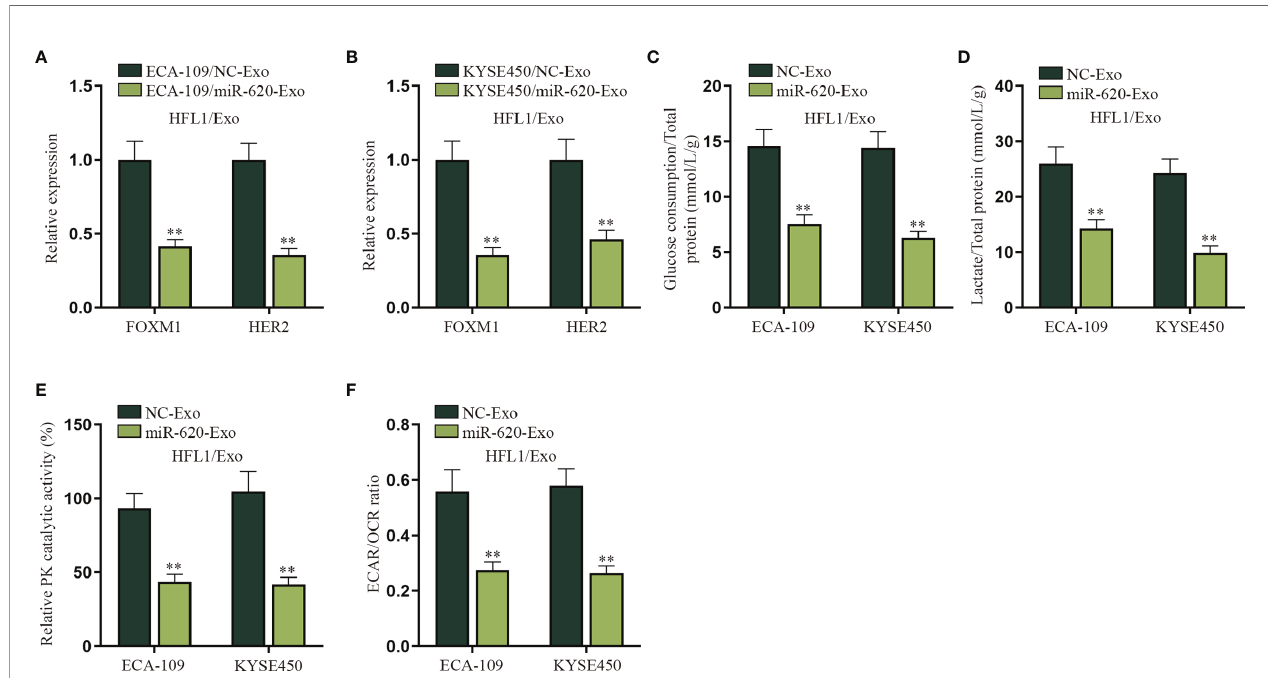
FIGURE 6 | Exosomal miR-620 inhibits the aerobic glycolysis of lung fi broblasts. (A, B) qRT-PCR was used to detect the expression of FOXM1 and HER2 in HFL1/ Exo cells receiving ECA-109/miR-620-Exo and KYSE450/miR-620-Exo. (C – F) qRT-PCR was utilized to detect the glucose consumption, total lactate protein, relative PK catalytic activity, and the ECAR/OCR ratio in HFL1/Exo cells accepting different cancer-secreted exosomal miR-620. ** p <